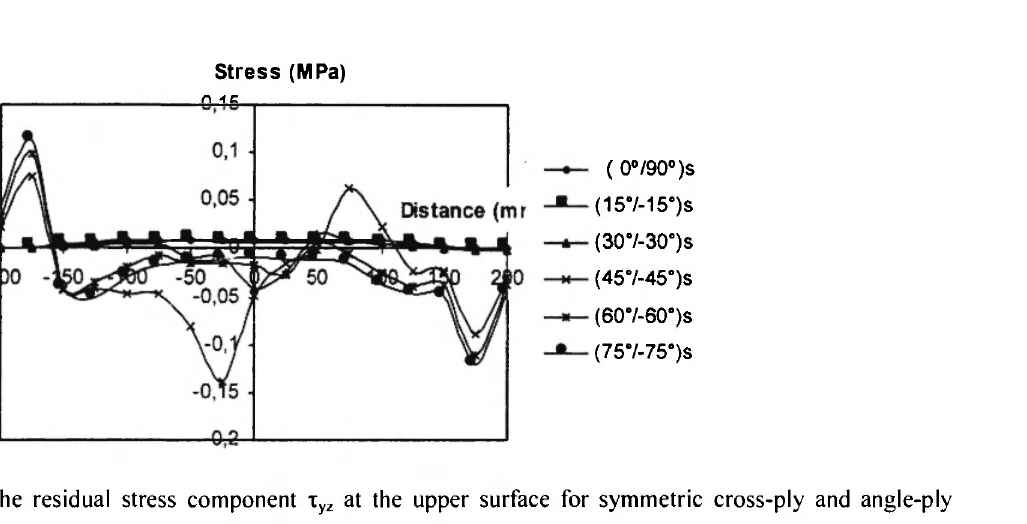
Fig. 12: Variation of the residual stress component x yz at the upper surface for symmetric cross-ply and angle-ply laminated plates.